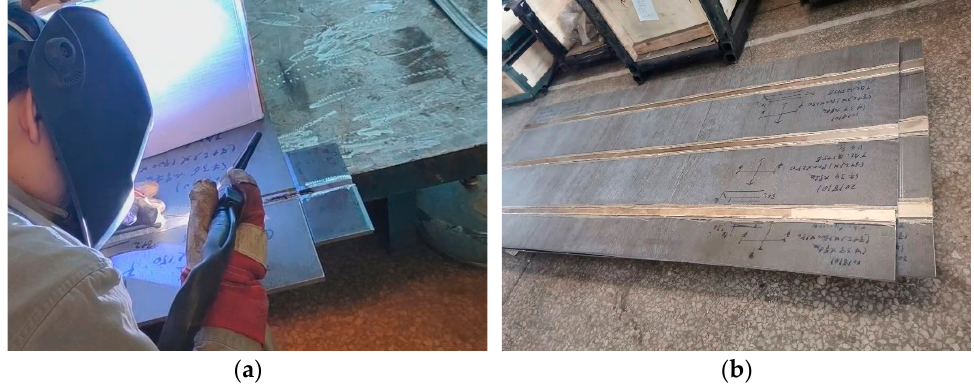
Figure 4. Manufacture of TC bimetallic steel welding plates. ( a ) Welding process, ( b ) TC bimetallic steel welding plates.